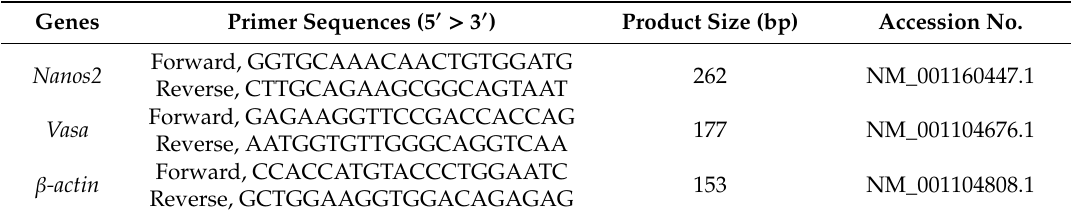
Table 1. Primer sequences used in this